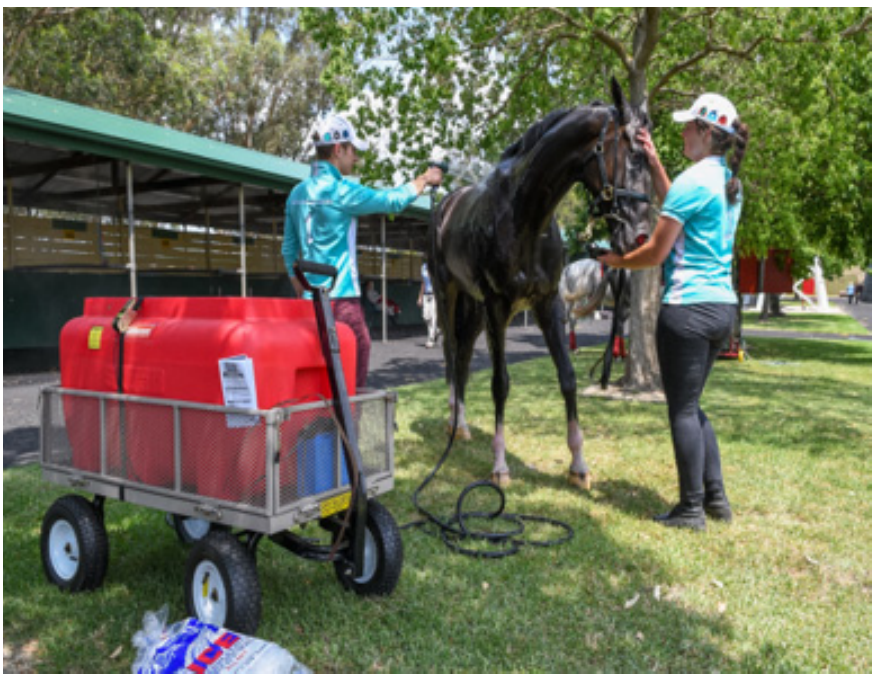
Figure 9. Level 1 EHI. It is difficult to show an irritable, restless horse in a still photograph. This horse has just raced and has a level of distress, with elevated heart and respiratory rates. The horse handlers have identified its requirement for a cooling intervention and have accessed the mobile cooling device, which contains ice-cold water. Veterinarians need to be always on hand to provide advice and monitor horses during the cooling process. Source—J Equine Vet Ed, 2021.